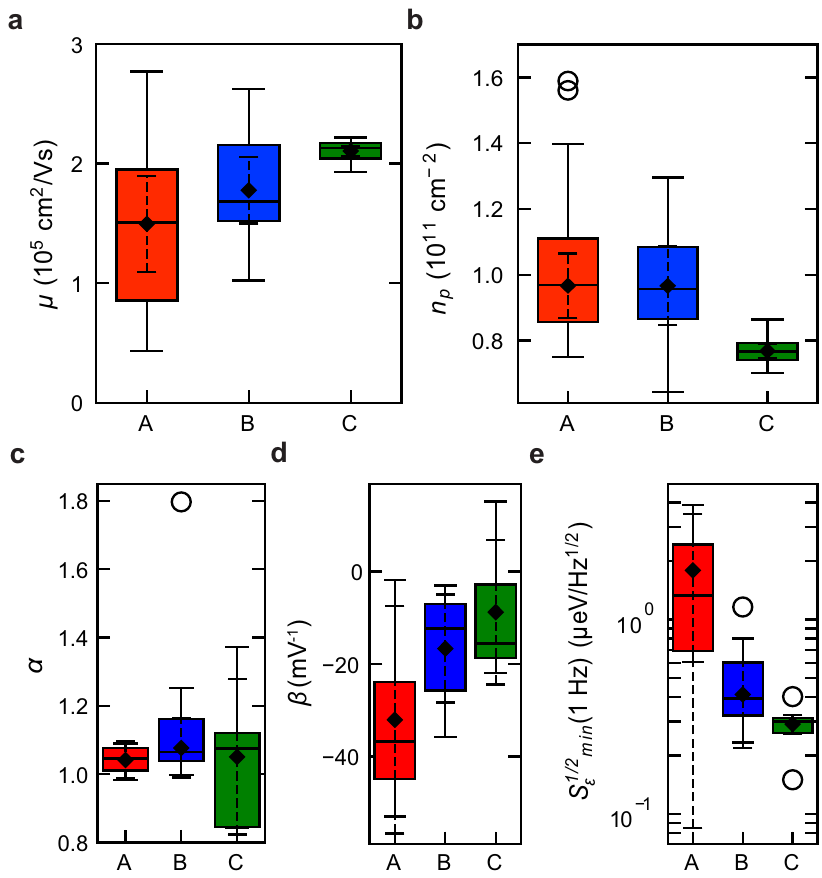
Fig. 3 | Distribution oftransport propertiesand charge noise. a , b Distributions of mobility μ measured at n =6×10 11 cm − 2 and percolation density n p for hetero- structure A (red, 20 H-FETs measured, of which 16 reported in ref. 32 ), B (blue, 16 H-FETs measured of which 14 reported in ref. 32 ), and C (green, 22 H-FETs mea- sured). c – e Distributions of noise spectrum power law exponent α , coef fi cient β